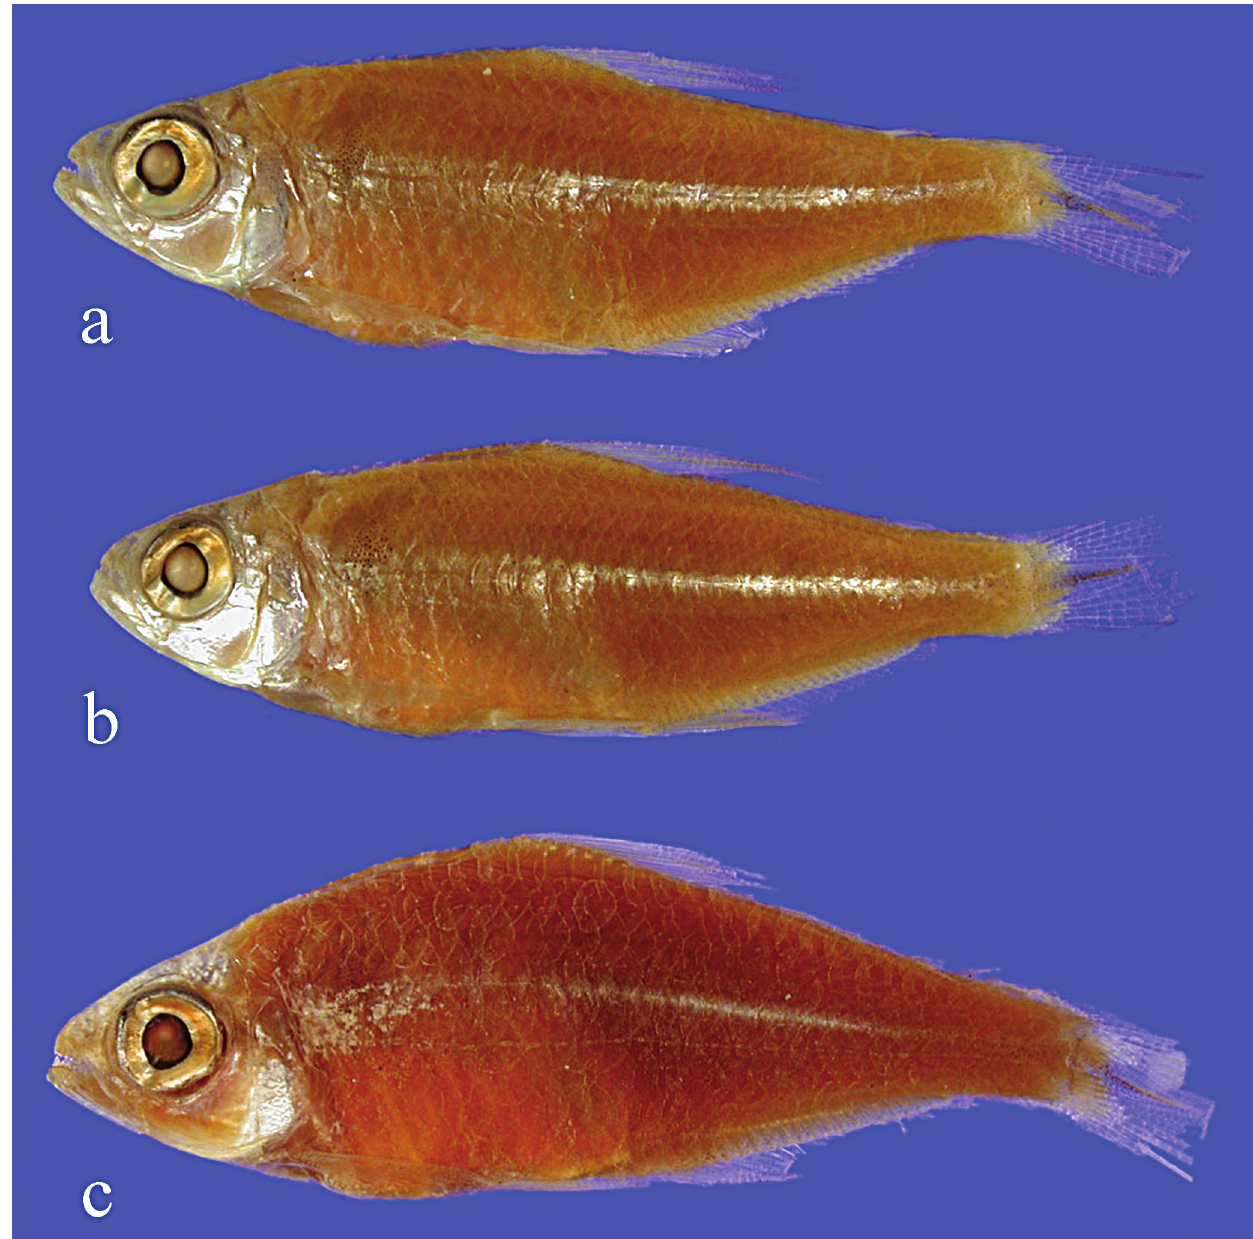
Fig. 1. Astyanax multidens : ( a ) syntype, MCZ 89559, 29.2 mm SL, rio Amazonas at Óbidos, ( b ) syntype, MCZ 89559, 30.0 mm SL, rio Amazonas at Óbidos, ( c ) MCZ 20826, 36.3 mm SL, rio Amazonas at